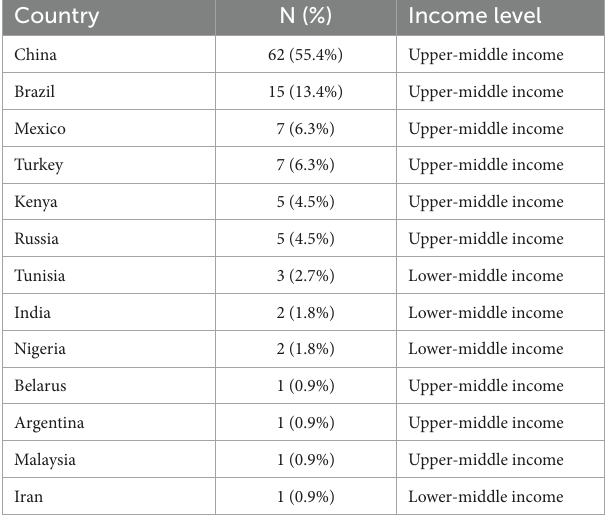
TABLE 1 Articles included in the review according to income